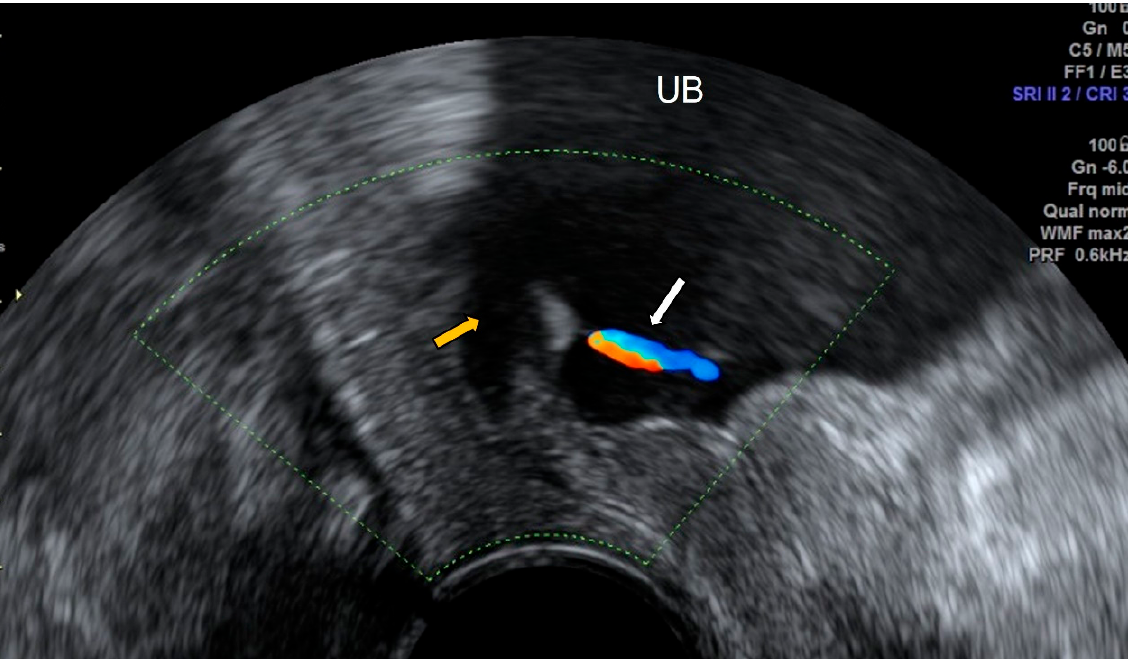
Figure 14. Transvaginal ultrasound shows a ureterocele (yellow arrow). Color Doppler demonstrates the flow of urine (white arrow) toward the urinary bladder (UB).